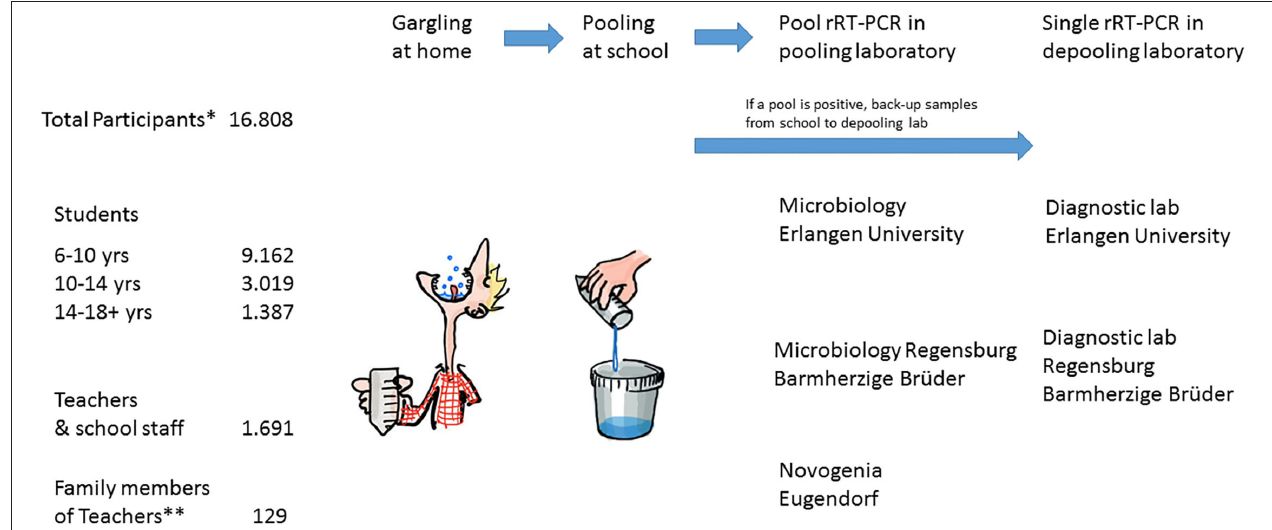
FIGURE 2 | Study design and numbers of the WICOVIR study as of May 12, 2021. *Participant numbers change over time, as new schools were included and some schools/individuals may have dropped out while others joined. **In pilot the phase, we explored teacher pools (as no clearance for student tests was yet available) and allowed family members of teachers to participate in these teacher